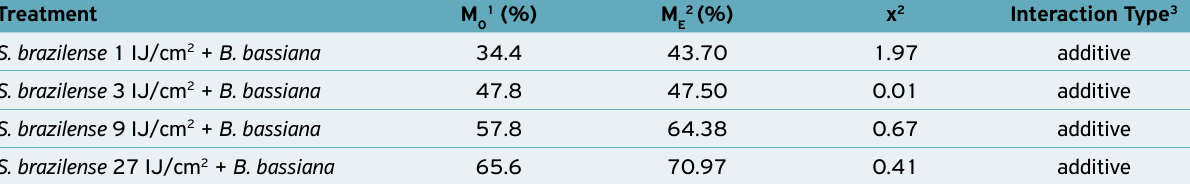
Table 3. Interaction between Steinernema brazilense and Beauveria bassiana applied in the field to control larvae of Conotrachelus humeropictus . Treatment